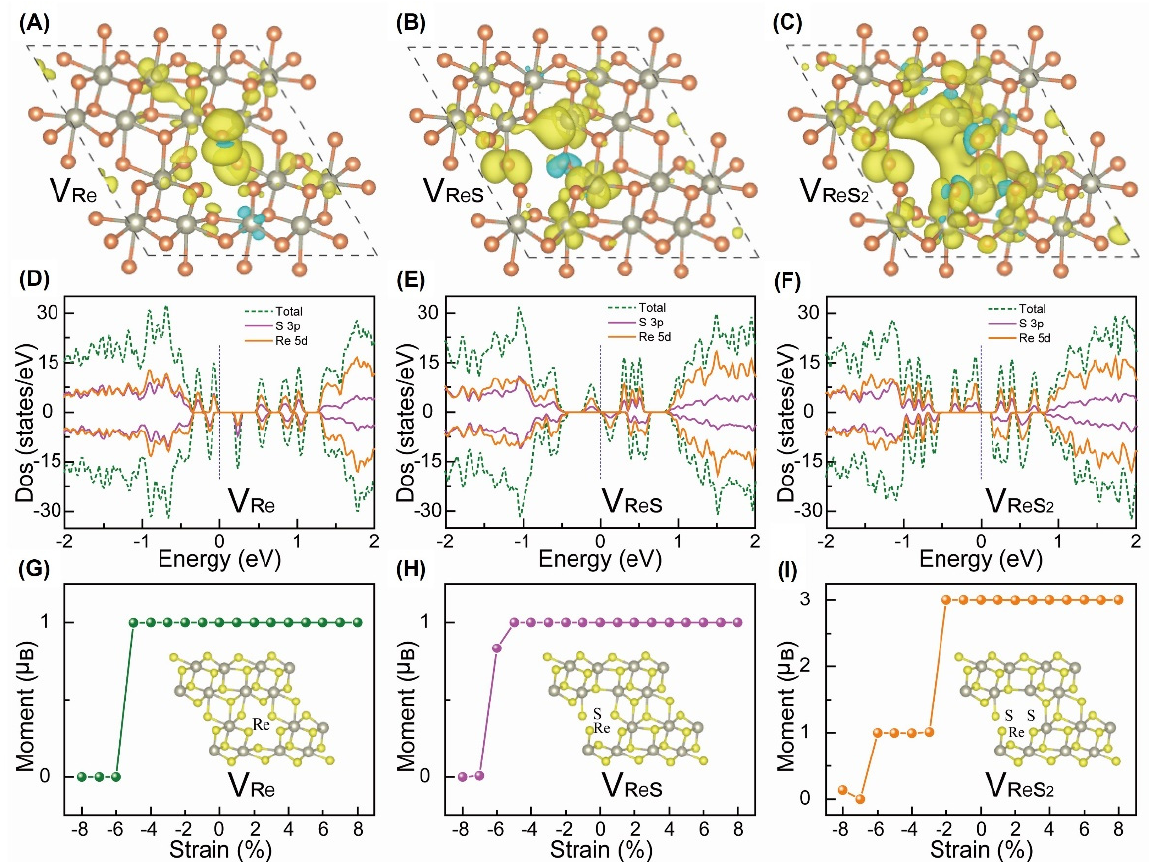
Figure 12. ( A − C ) Magnetic density maps of V Re , V ReS , and V ReS2 of ReS 2 crystals with up (down) spin densities plotted in yellow (blue) for isosurfaces at 0.001 eÅ − 3 , respectively. ( D − F ) Orbital projection density of states (PDOS) of V Re , V ReS , and V ReS2 of ReS 2 crystals, respectively. ( G − I ) The variation in magnetic moment of ReS 2 crystal with V Re , V ReS , and V ReS2 under biaxial compressive and tensile strain. The inset shows the corresponding crystal structure with vacancy defects. Please note that when the strain value is negative, the strain is compression strain; when the strain is positive, it is a tensile strain. Reprinted with permission from [27]. Copyright 2019, John Wiley and Sons.